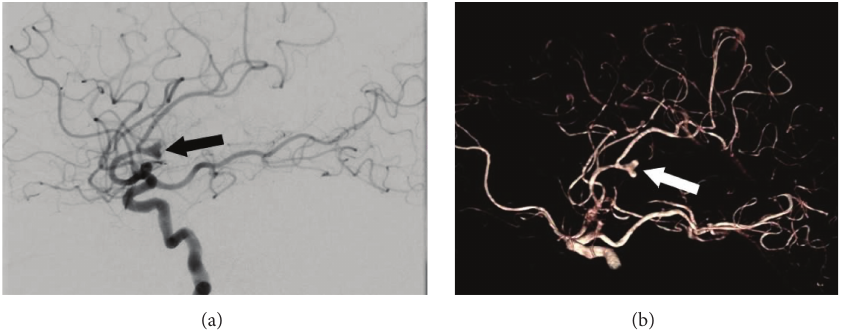
Figure 2: (a) Cerebral angiogram demonstrating left middle cerebral artery M2 segment mycotic aneurysm (black arrow). (b) 3D volume- rendering technique of the same aneurysm (white